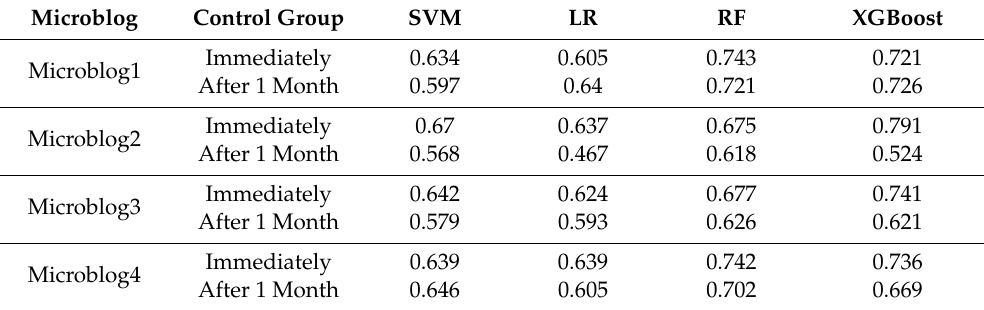
Table 9. The F1 Score considering duration after rumor